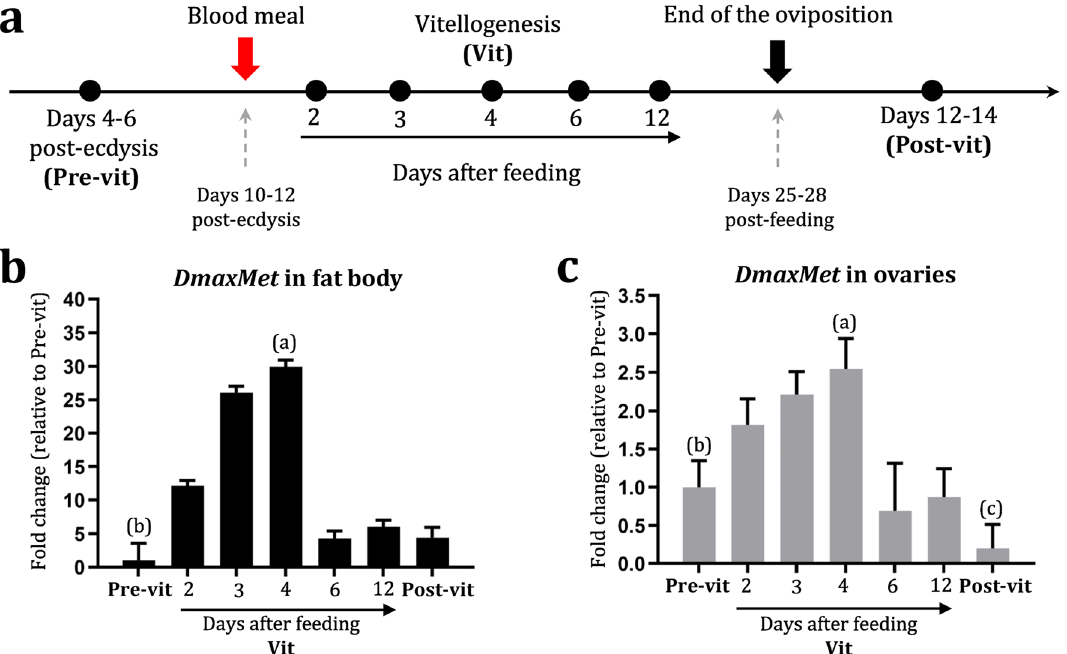
Figure 2. mRNA temporal profiles of DmaxMet throughout the reproductive cycle. ( a ) Experimental scheme showing the timeline of sampling days. ( b ) Temporal expression of DmaxMet in fat body ( P < 0.05 vs. Pre- vit; 2, 6, 12 days after feeding and Post-vit; P < 0.005 vs. 2, 3, 4 days after feeding). ( c ) Temporal expression of DmaxMet in ovaries ( P < 0.05 vs. 6 and 12 days after feeding and Post-vit; P < 0.01 vs. 2, 3, 4 days post feed; P < 0.05 vs. Pre-vit). The results are shown as mean ± SD of three independent experiments. Each experimental point includes samples from insects processed individually (n = 3). The statistical analyses were